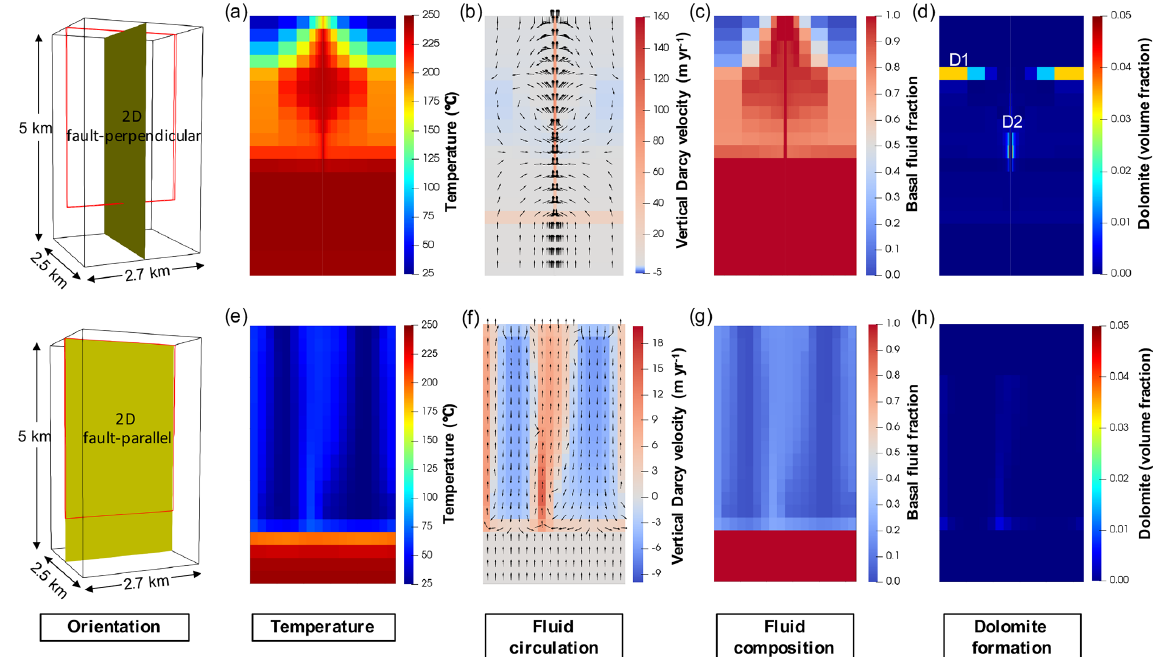
Figure 2. Simulation results for 2D fault-perpendicular (a–d) and fault-parallel (e–h) models showing heat transfer, fluid flow (with rep- resentative streamlines), basal fluid fraction, and dolomite distribution at 30kyr. The yellow planes on the left of each row represent the orientation of 2D displays, and the red outlines highlight the FDZ. Darcy velocities are positive when the flow is upward and negative when the flow is downward. Note the difference in scale for Darcy velocity between the 2D fault-perpendicular and fault-parallel